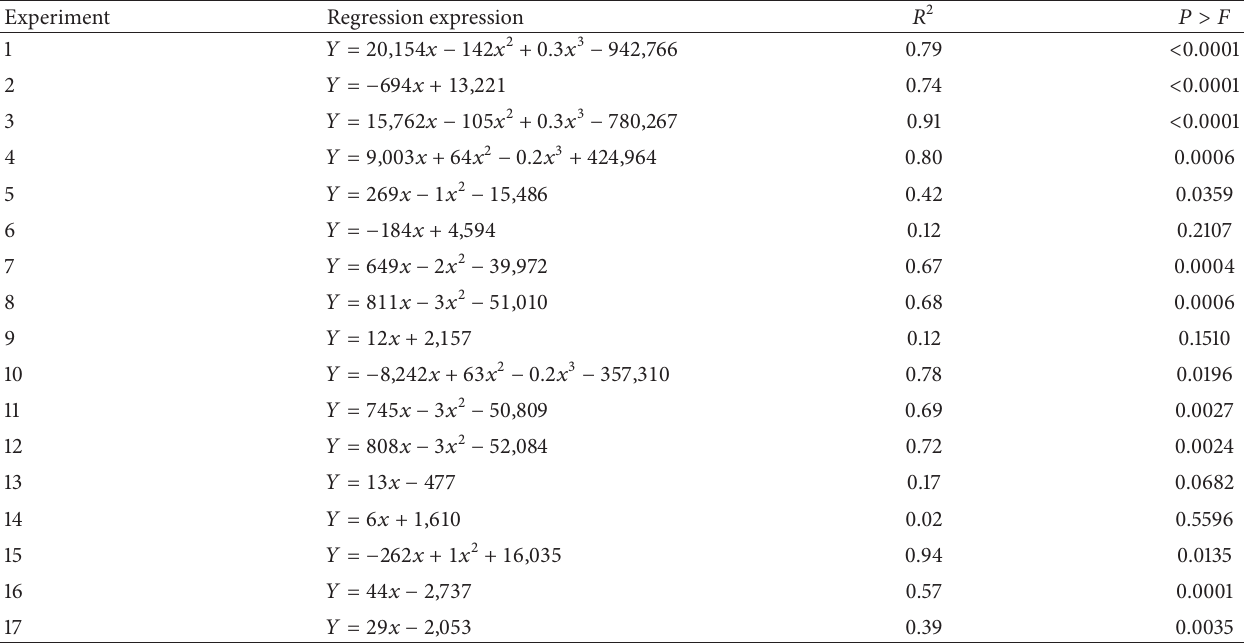
Table 3: Regression expressions, regression coefficients, and 𝑃 > 𝐹 for economic value versus days from peanut emergence to digging from 17 trials conducted during 2003–2012.